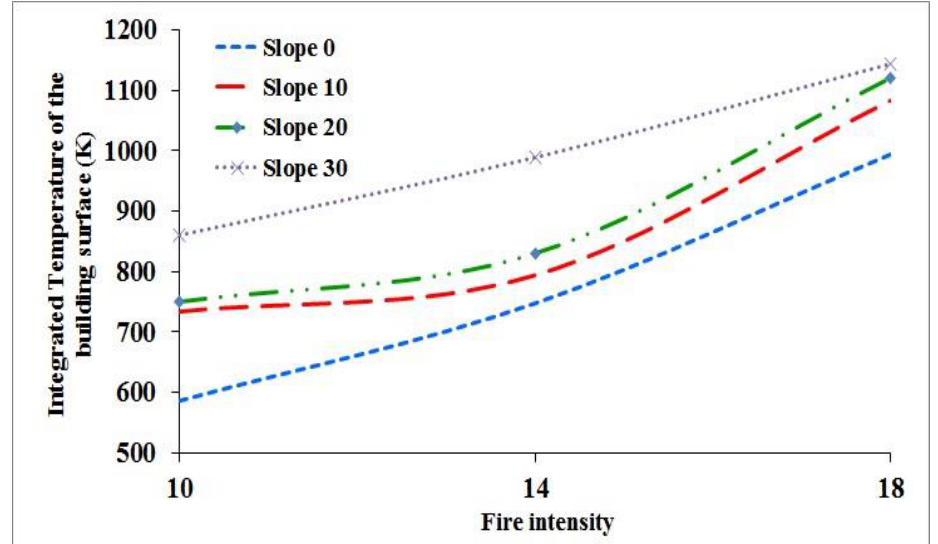
Figure 5. Integrated temperature on the building surface versus the fire intensity for a constant U ref = 6 m/s and different terrain slopes. U ref = 6 m/s and different terrain